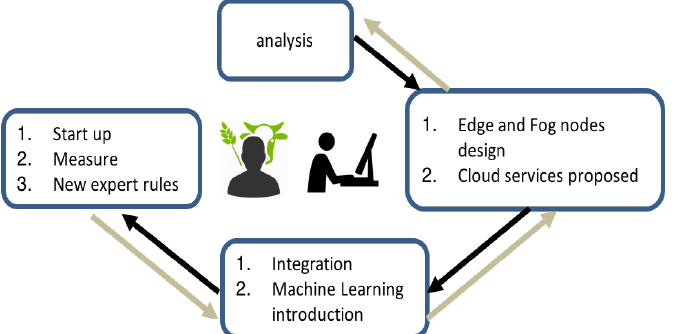
Figure 3. User centred model based on design and integration of edge and fog communication levels. Cloud services and machine learning processes are integrated using this method.